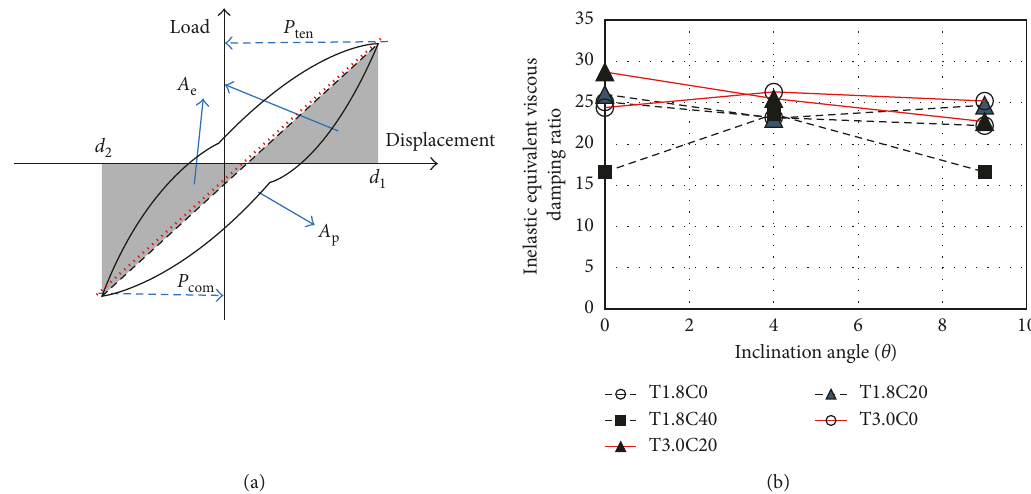
Figure 9: Equivalent viscous damping ratio. (a) Determination of the equivalent viscous damping ratio. (b) Equivalent viscous damping ratio of the